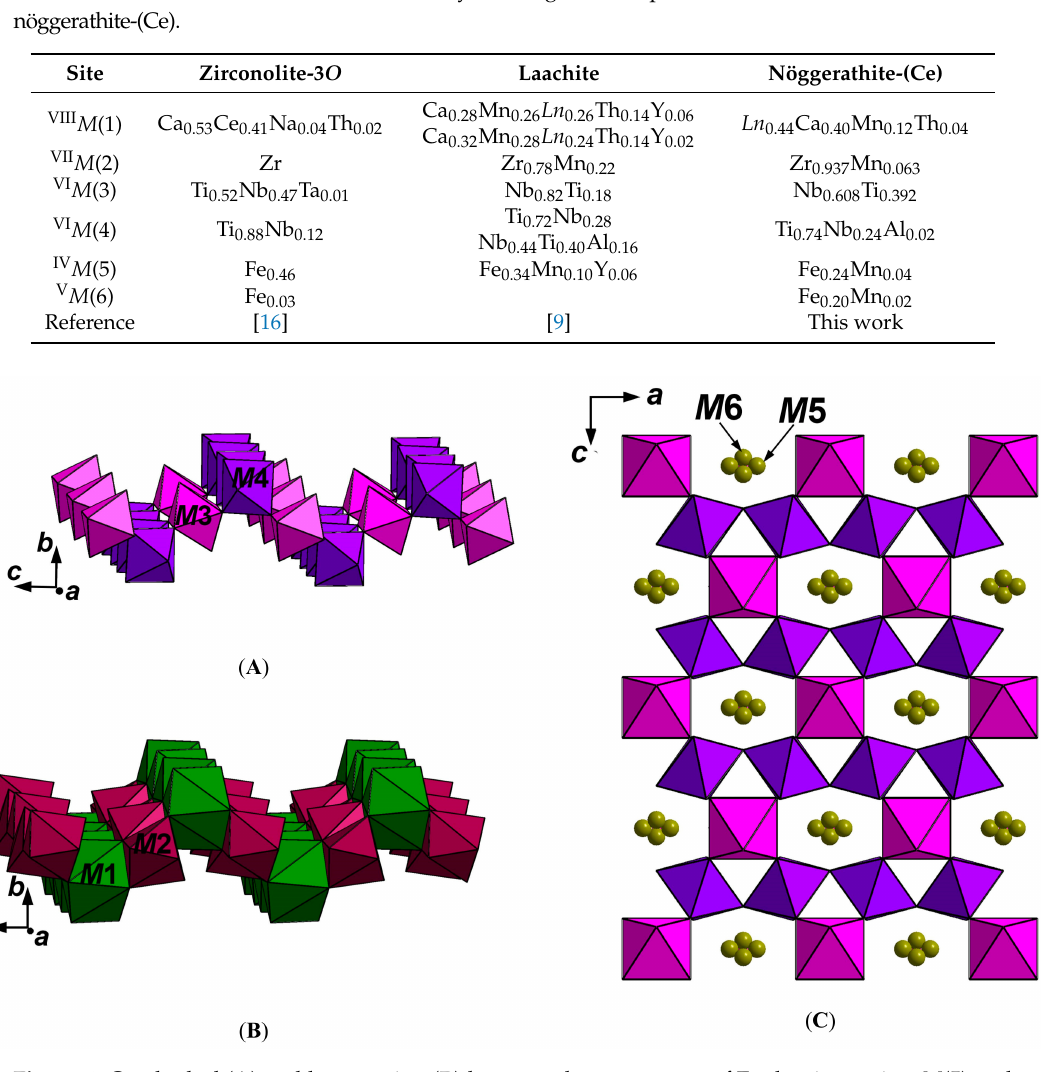
Figure 4. Octahedral ( A ) and large-cation ( B ) layers and arrangement of Fe-dominant sites M (5) and M (6) inside the octahedral layer ( C ) in the structure of